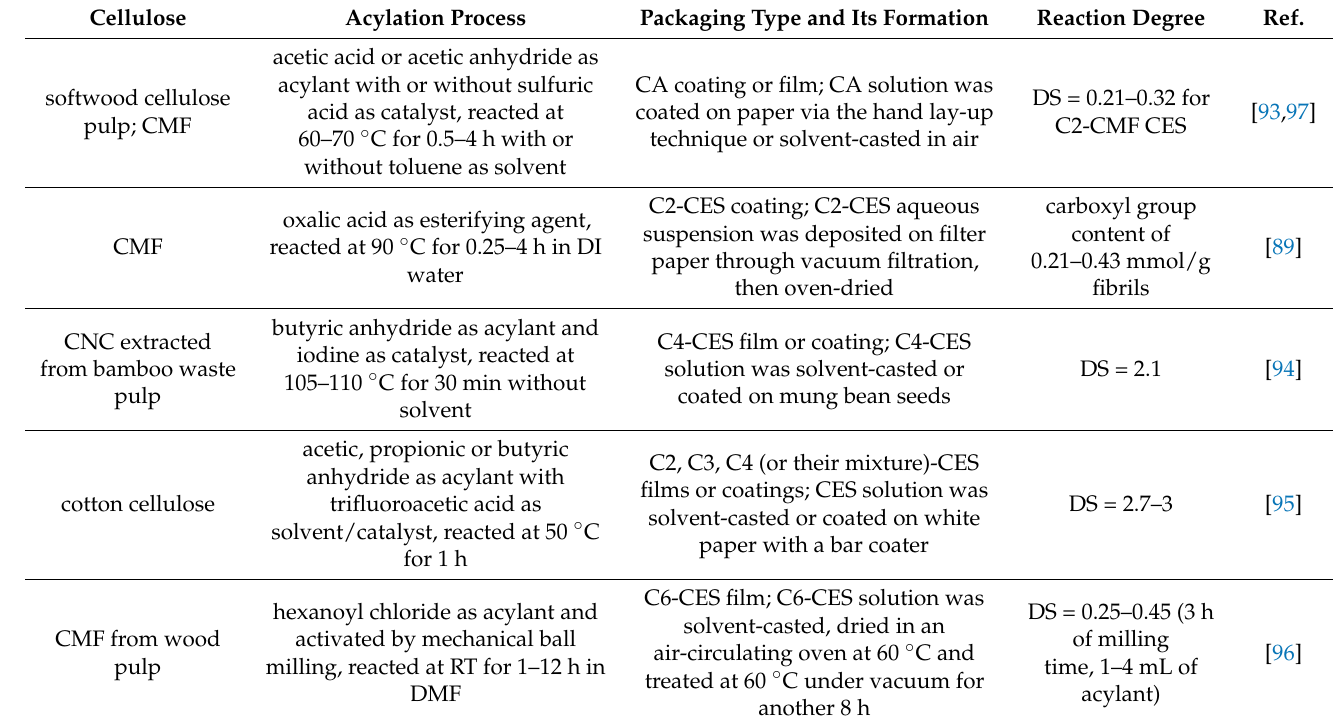
Table 2. Esterification of cellulose using C2–C6 acylants, reaction degree, and the associated packaging forming